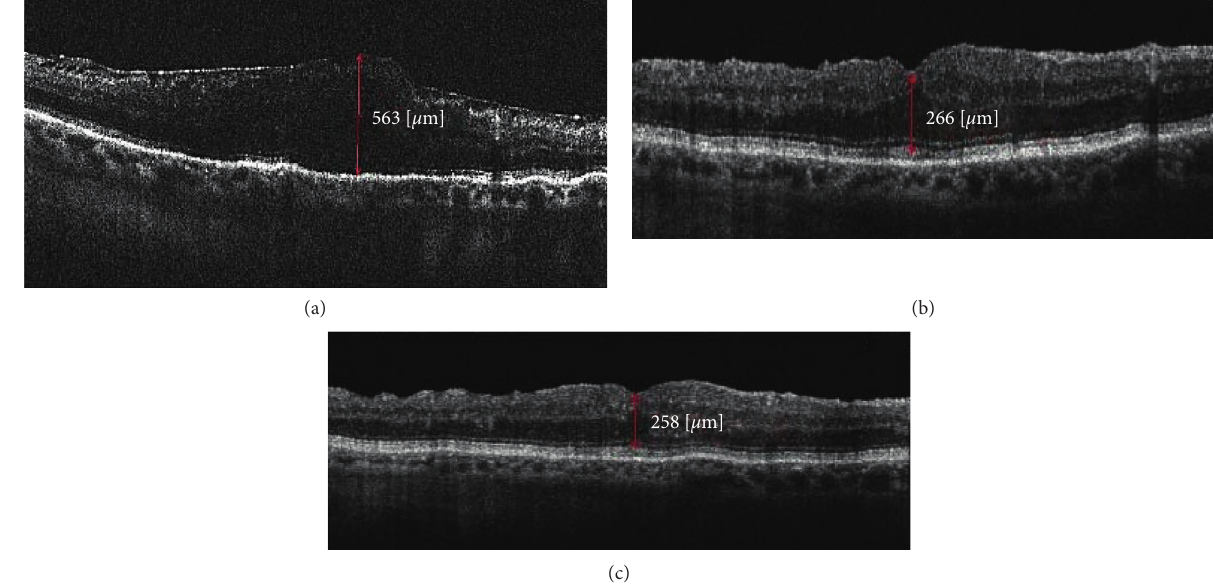
Figure 2: OCT scan of the patient with complete vitrectomy with ERM removal. ((a)) Preoperative scan showing ERM with loss of foveal contour, CMTmeasuring 563 μ , and BCVA measuring 0.5 logMAR. ((b)) The one-month postoperative scan showing a reduction in CMTto 266 μ with BCVA measuring 0.8. ((c)) After a year, CMT was 258 μ and BCVA improved to 0.9